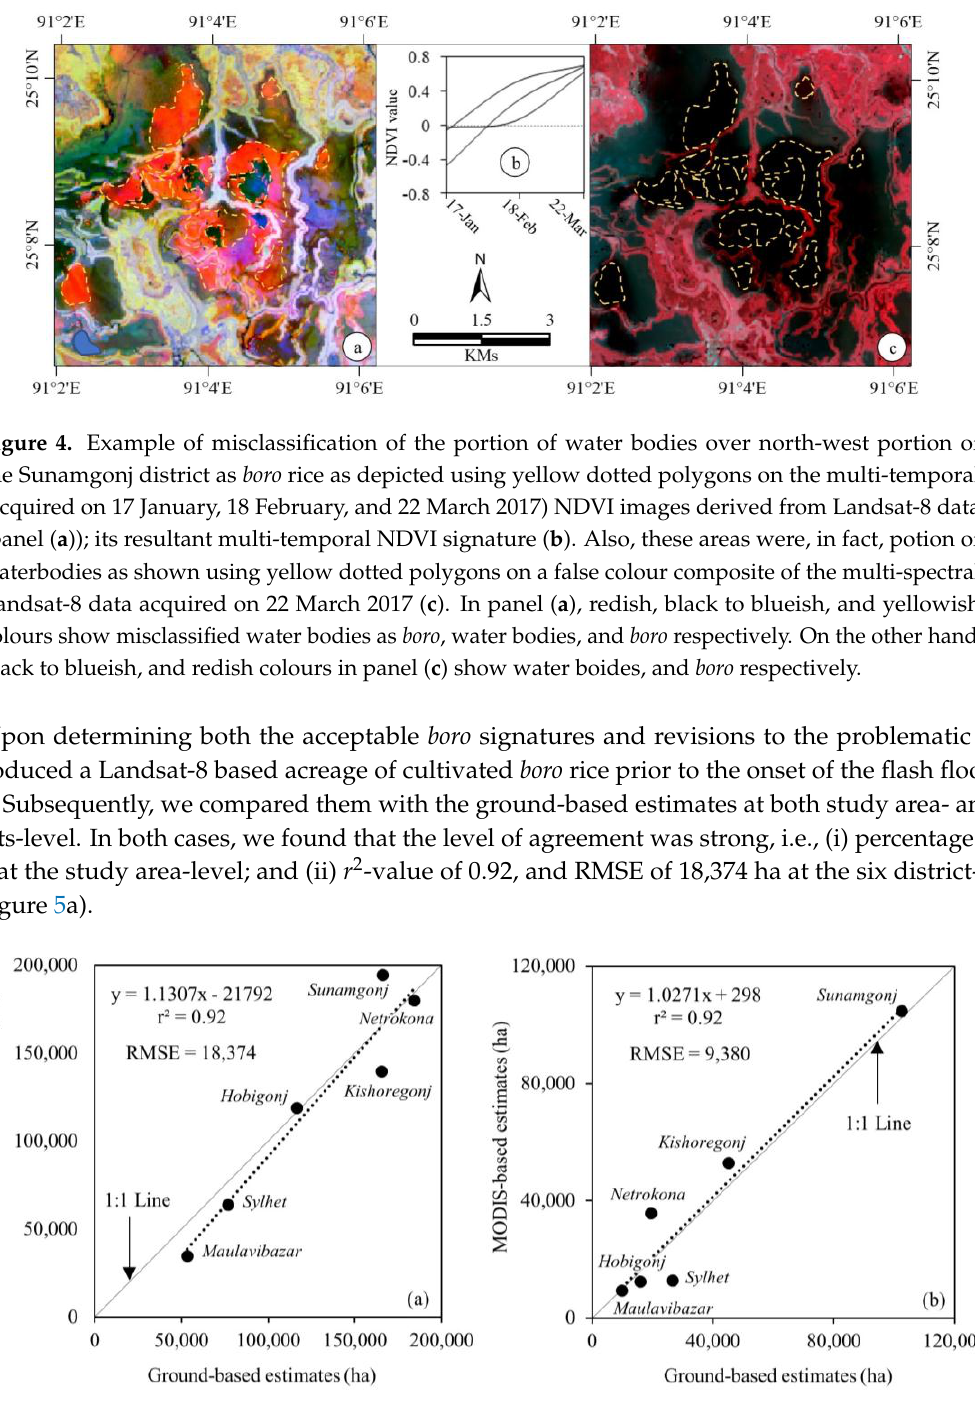
Figure 5. Relations between ground and remote sensing-based estimates of boro cultivated ( a ) and damaged ( b ) at six districts, where the dash lines represented the regression lines.